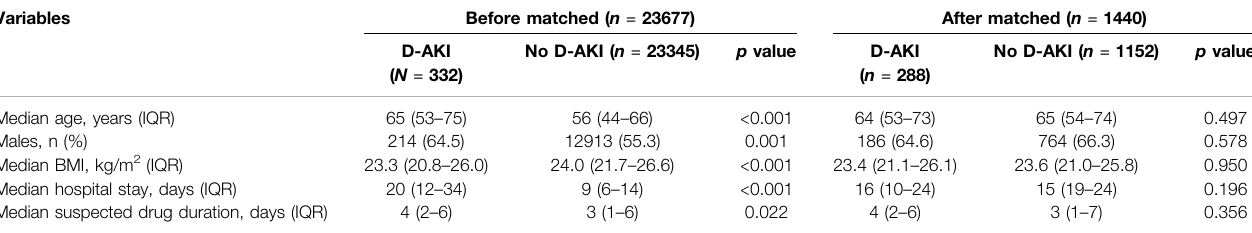
TABLE 1 | Baseline characteristics of patients before and after propensity score matched